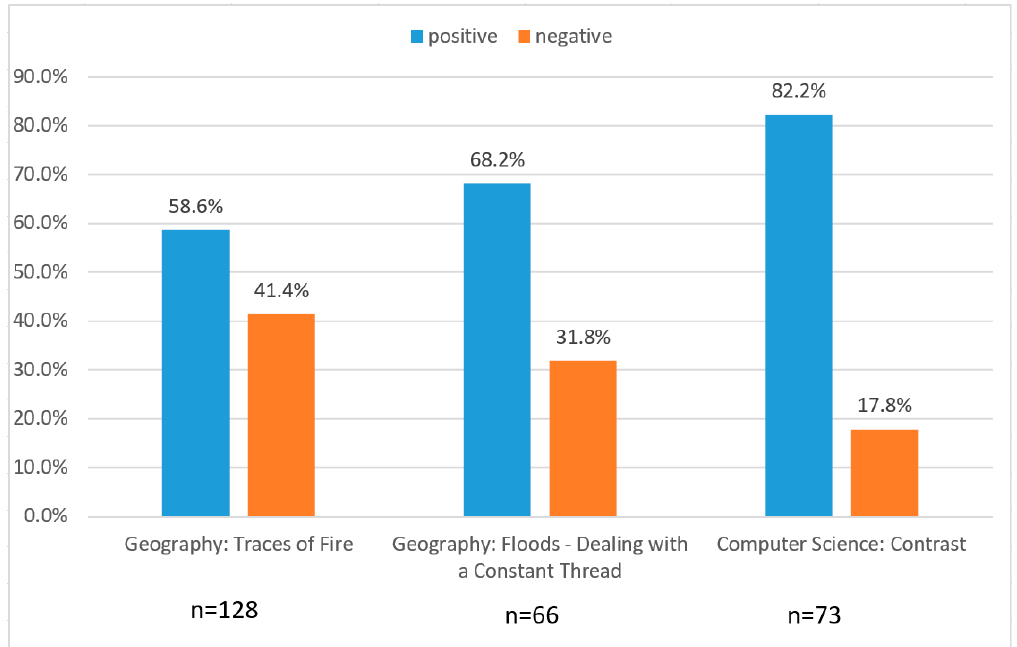
Figure 8. Pupils reacting positively (agreeing strongly or agreeing) or negatively (disagreeing or disagreeing strongly) to the statement “The illustrations and animations are helpful for completing the tasks” in different learning modules.